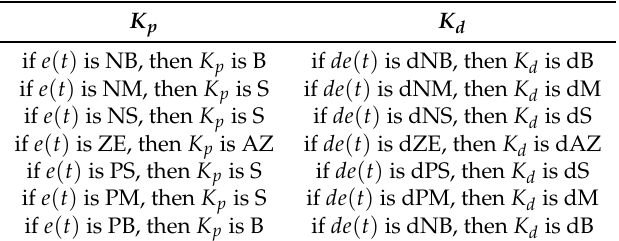
Table 3. Controller gains rules.